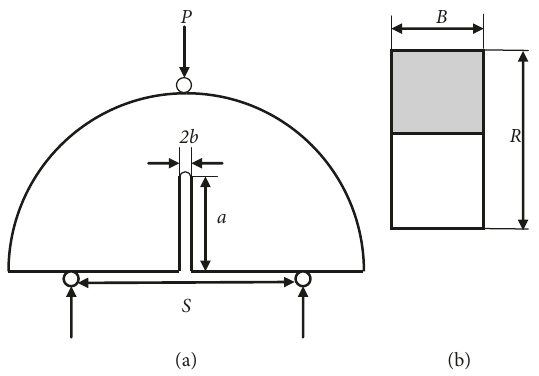
Figure 1: Loading diagram of the NSCB specimen: (a) plane diagram and (b) cross-sectional diagram.